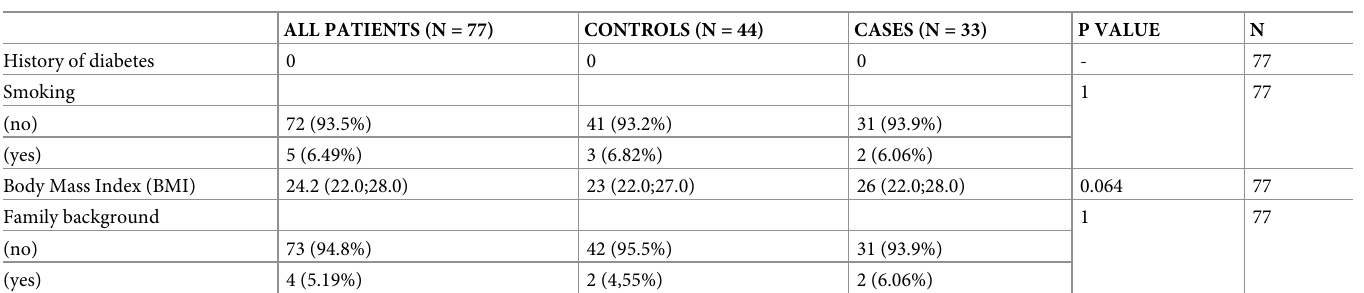
Table 1. Baseline characteristics of cases and controls.